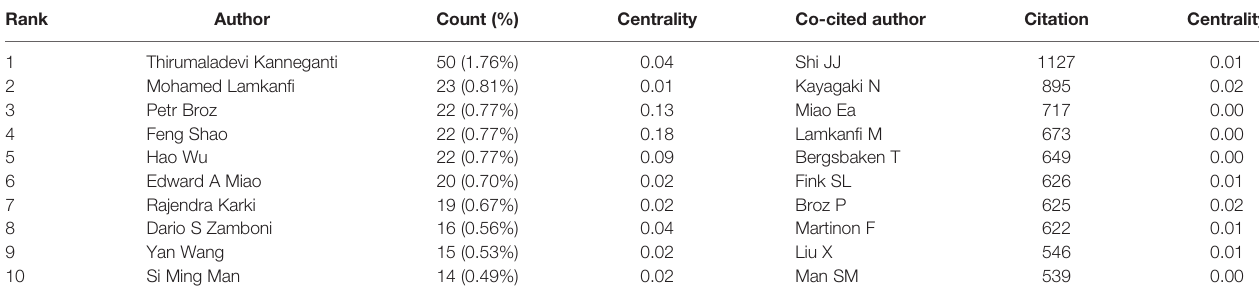
TABLE 2 | Top 10 authors and co-cited authors related to